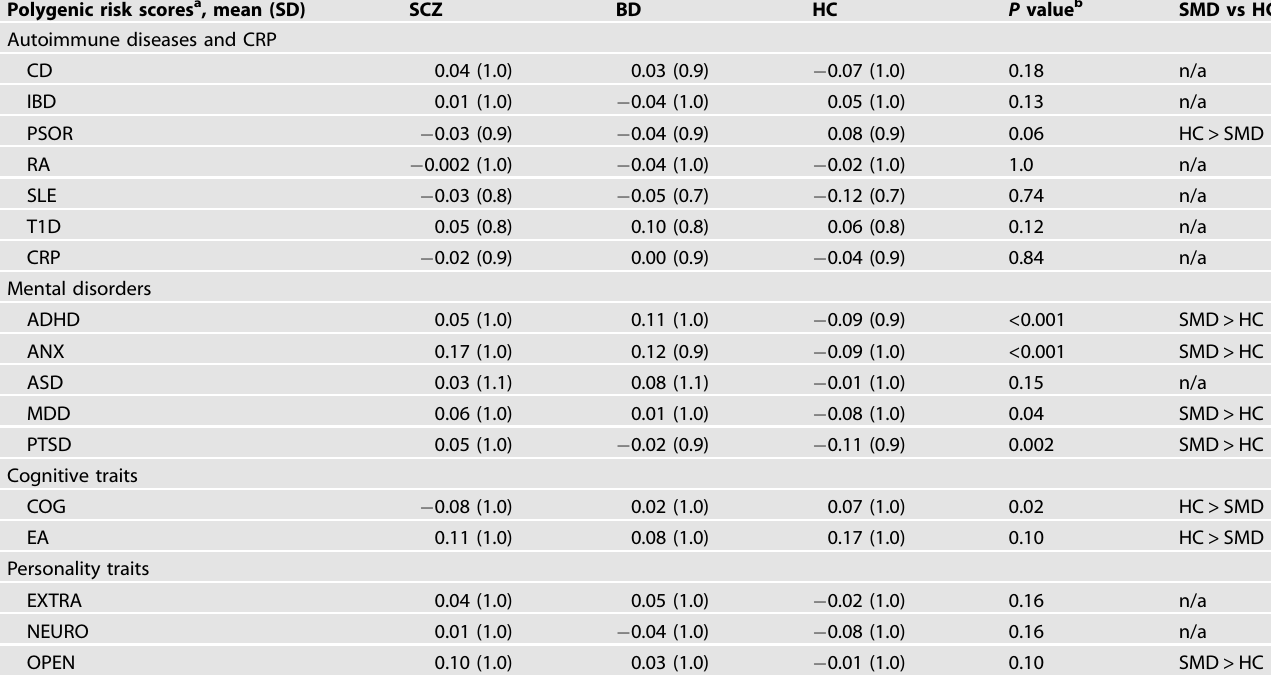
Table 2. Polygenic risk